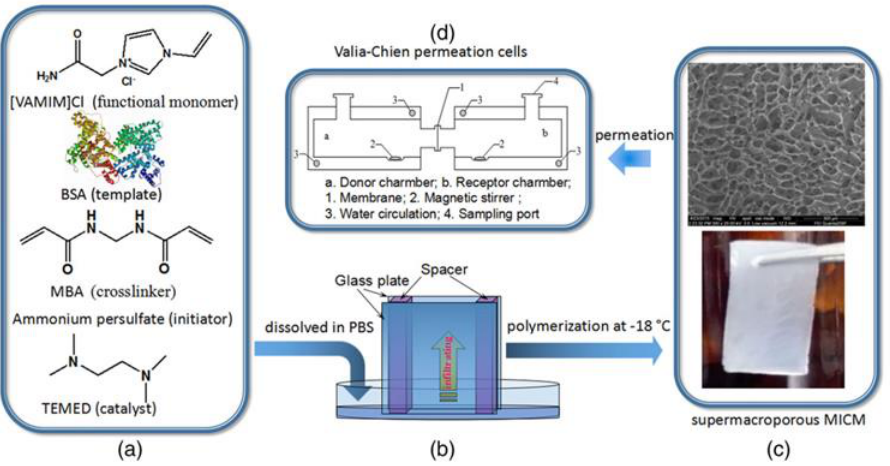
Figure 13. Pre-polymerization mixture components during the synthesis of the cryogel bovine serum albumin-imprinted membrane fabricated by Fan et al. ( a ); infiltration of the mixture between two glass plates ( b ); SEM image (upper) and photo (down) of the obtained free-standing flat-sheet membrane ( c ); diffusion cell used in permeation tests ( d ). (Reprinted with permission from Ref. [278]. Copyright 2018 John Wiley and Sons.)